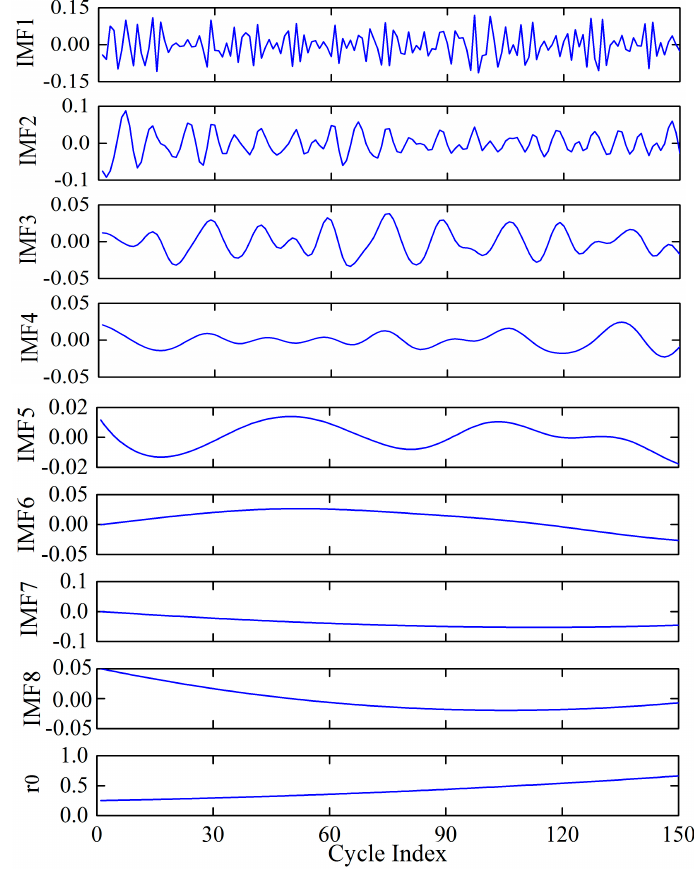
Figure 5. The decomposed results of the original SDI series.